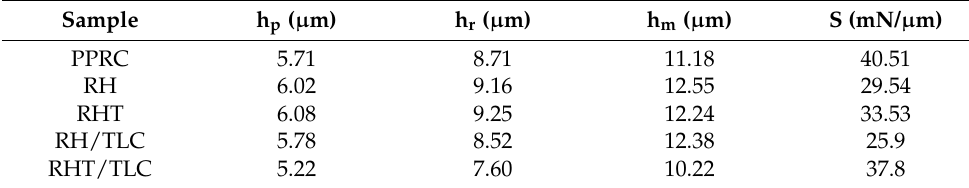
Figure 4. QCSM data ( a ) load–depth curve, ( b ) tangent drawn on unloading curves to calculate h r . Table 2. Values of plastic depth h p , elastic deformation h r , maximum penetration depth h m , and contact stiffness S calculated by nanoindetation at P max = 100 mN.